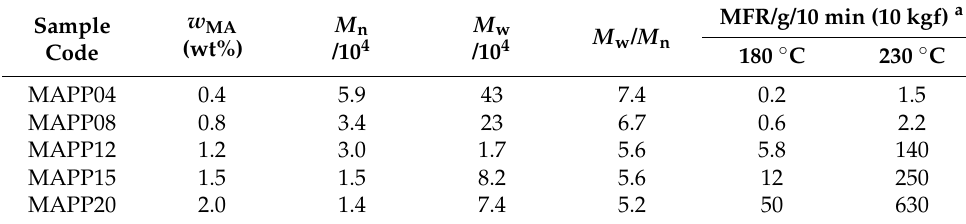
Table 1. Properties of MAPP used. Reprinted from Ref. [33]. Copyright Elsevier Ltd. (2019).